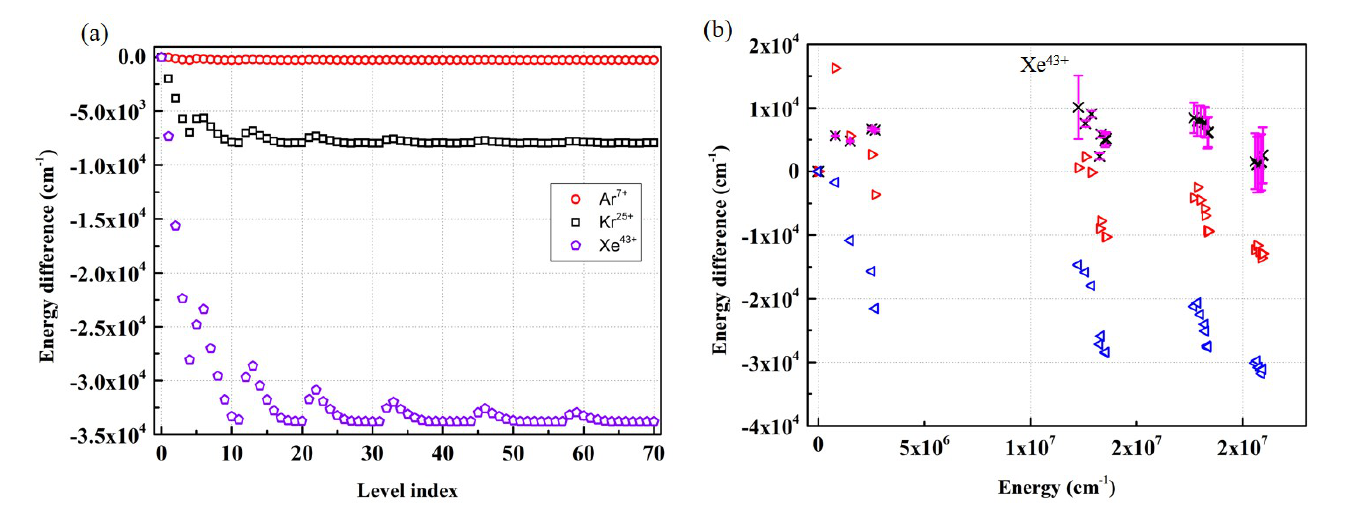
Figure 2. ( a ) The difference in the present RCI and RSCF energies for Ar 7 + , Kr 25 + and Xe 43 + ; ( b ) the difference in the present RSCF (leftward triangle), RCI (star) and RCI without Breit interaction (rightward triangle) energies with respect to the NIST ASD [48] for Xe 43 + .